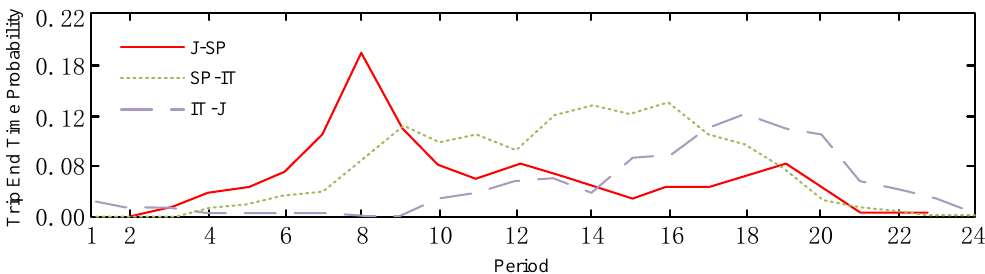
Figure 5. Probability distribution of the end time of user trips on non-work days.